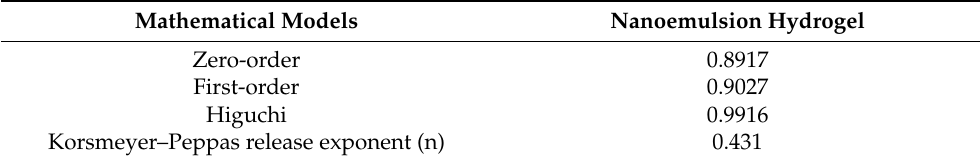
Table 5. Kinetics release